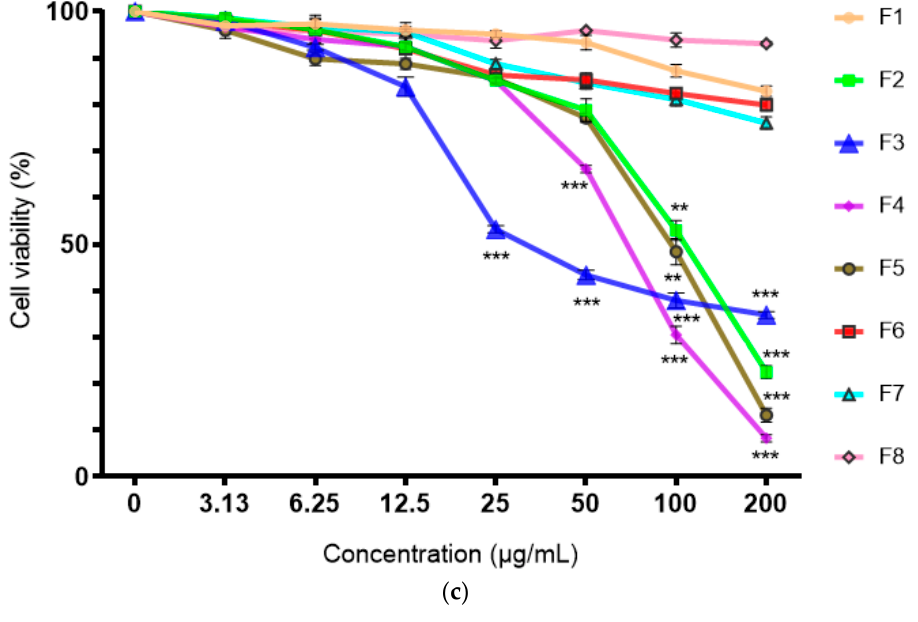
Figure 2. Cytotoxicity of C. vespertilionis ethyl acetate root fractions (F1–F8) determined using MTT assay on ( a ) MDA-MB-231, ( b ) MCF-7 and ( c ) 3T3. All values are expressed as mean ± SD and data with asterisks are significantly different at p < 0.05 when compared with the untreated group (control).